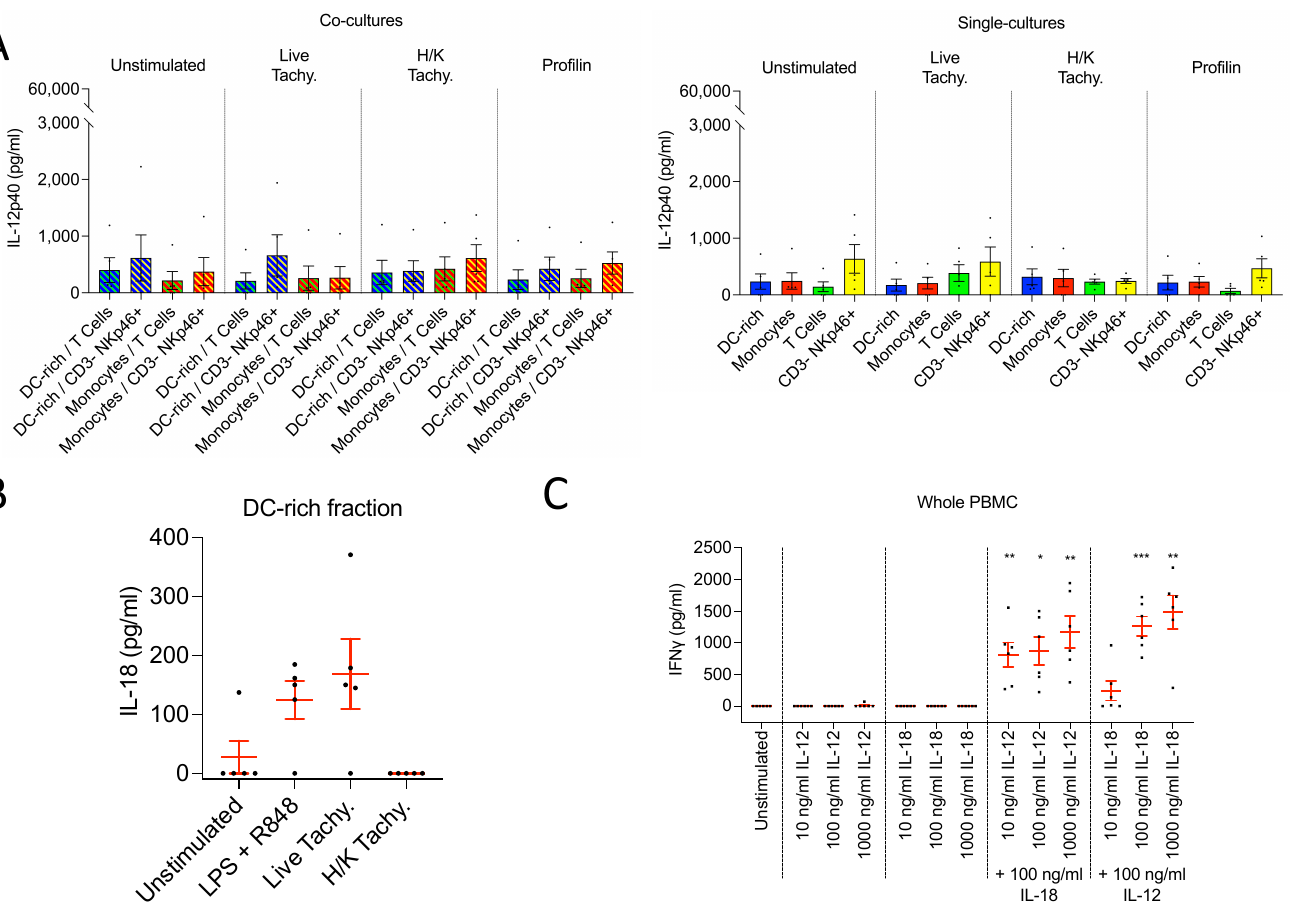
Figure 5. ( A ) IL-12p40 concentrations in the supernatants of porcine monocytes and DC-enriched PBMCs, in isolation and co-culture with T cells or CD3– NKp46+ cells, following 24 h stimulation with live and heat-killed T. gondii tachyzoites and recombinant profilin. Stimulations were performed with n = 5 different pigs. All cell types were stimulated in parallel from each pig. ( B ) Concentrations of IL-18 in the cell culture supernatants of DC-enriched PBMCs, following 24 h stimulation with TLR ligands or live or heat-killed T. gondii tachyzoites. Stimulations were performed with n = 5 different pigs. ( C ) IFN γ concentrations in the supernatants of cultured PBMCs following 48 h stimulation with different concentrations of recombinant IL-12p70 and/or IL-18, n = 6. Asterisks indicate statistical significance; paired t test; * p ≤ 0.05, ** p ≤ 0.01, *** p ≤